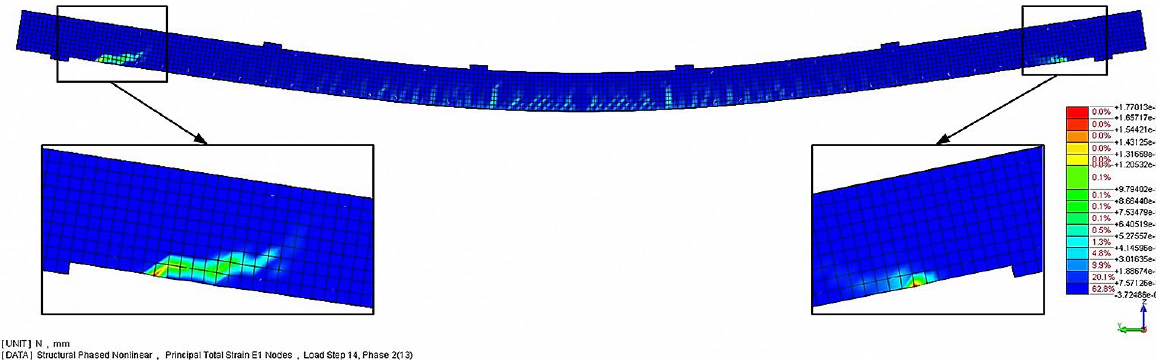
Fig. 10. View of the beam in FEM model at